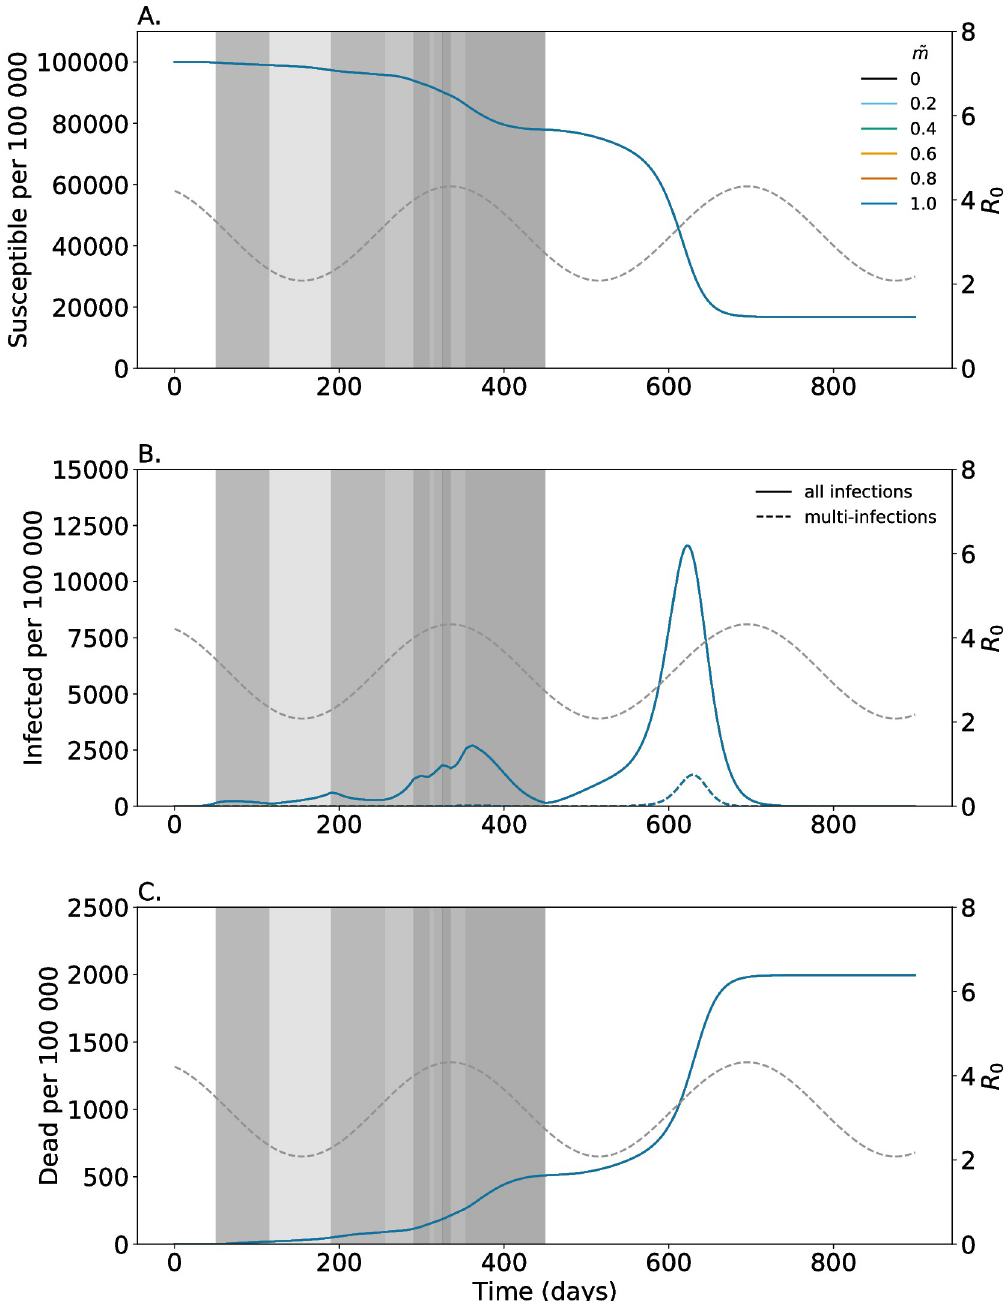
Fig 5. Likelihood to spread multi-infections. As in Fig 2 but colors are for different likelihoods of multi-infected individuals to spread multi-infections ( ~ m